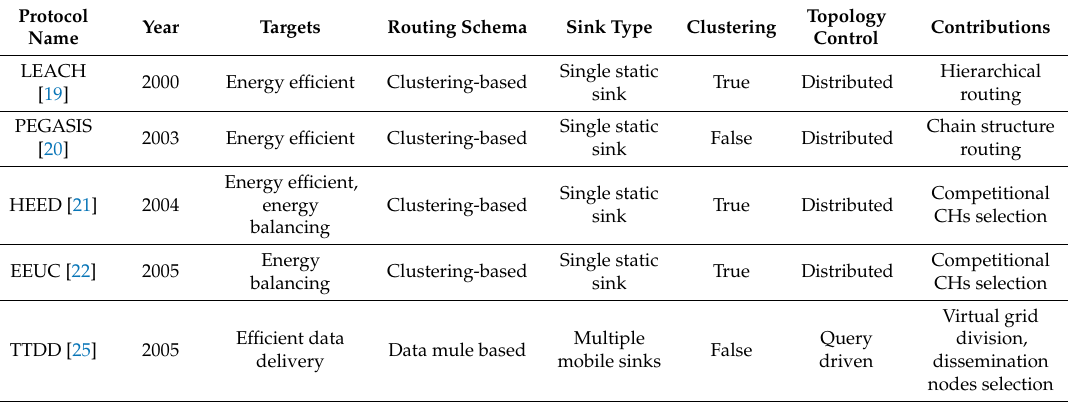
Table 1. Comparison of some mentioned routing